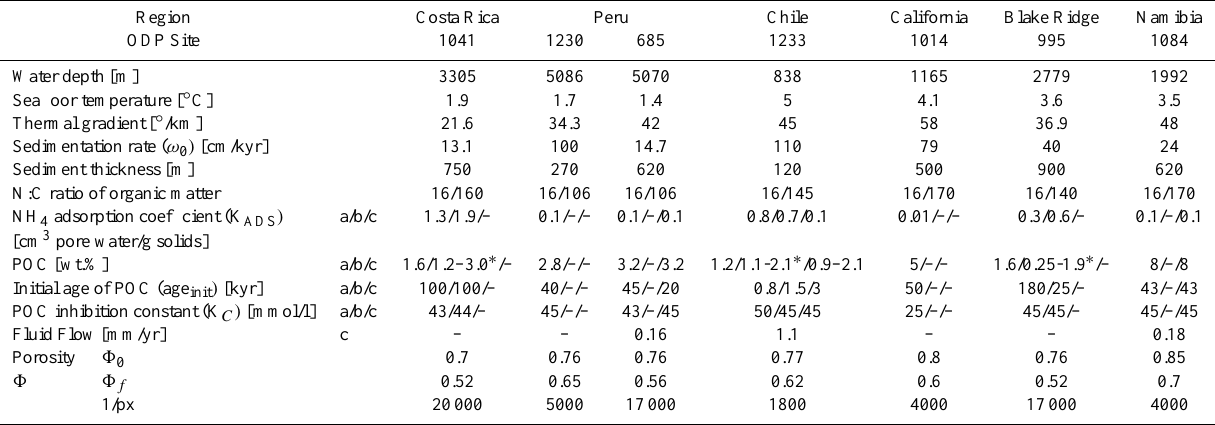
Table 1. Parameters, constants and coefficients of the modelled ODP Sites 1041 (Costa Rica), 685 and 1230 (Peru), 1233 (Chile), 1014 (California), 995 (Blake Ridge), and 1084 (Namibia). The values for the different model runs (constant POC input, varying POC input and fluid flow) are listed as a, b, and c. The porosity is calculated after Berner (1980) with the porosity at the surface ( 8 0 ) , at the lower boundary ( 8 f ) , and the coefficient for the decrease of porosity (px).